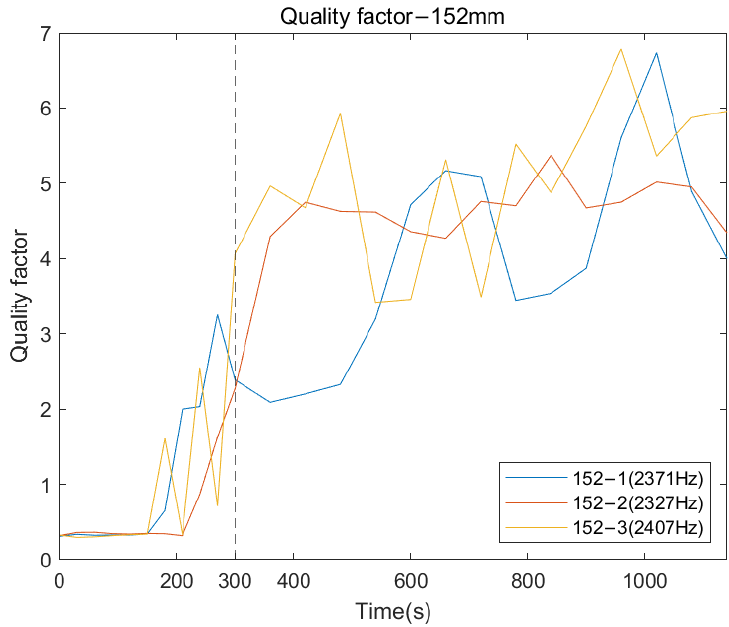
Figure 8. Quality factor of selected resonant peaks as a function of time.